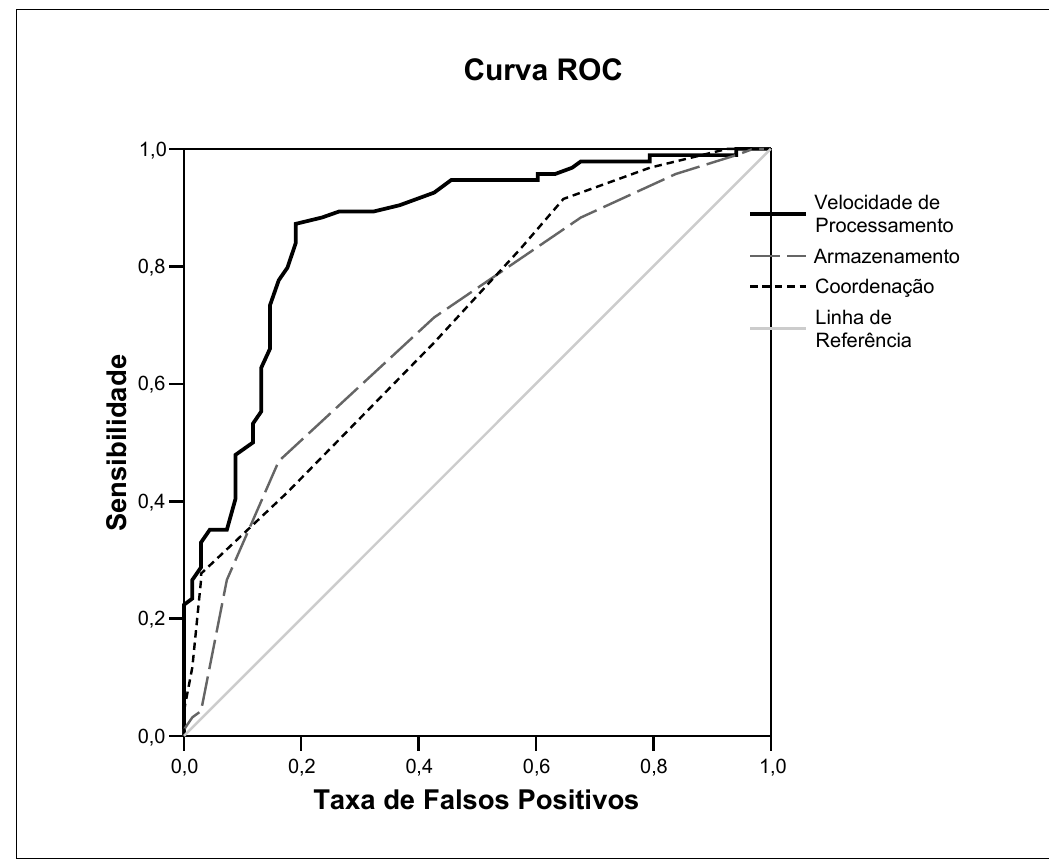
Figura 8 . Curvas ROC para os subtestes da BAMT na comparação entre controles jovens e idosos